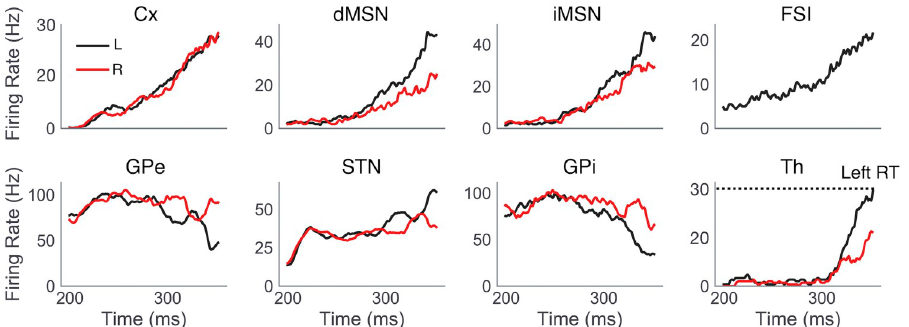
Fig 3. Single trial example of CBGT dynamics. Population firing rates of CBGT nuclei, computed as the average of individual unit firing rates within each nucleus in L (black) and R (red) action channels, are shown for a single representative trial in the high reward probability condition. The selected action ( L ) and corresponding RT (324 ms ) are determined by the first action channel to raise its thalamic firing rate to 30 Hz